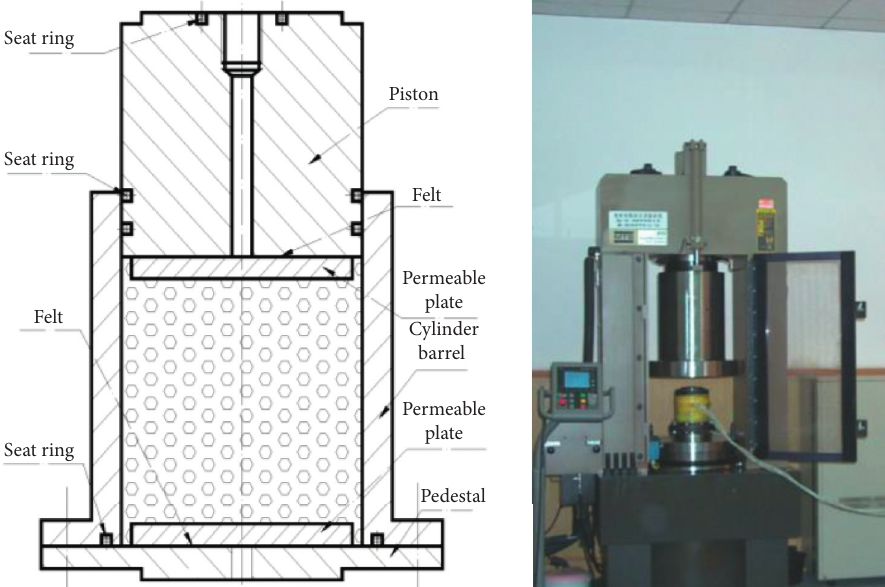
Figure 1: Experimental devices for the compaction of solid backfill materials [31].